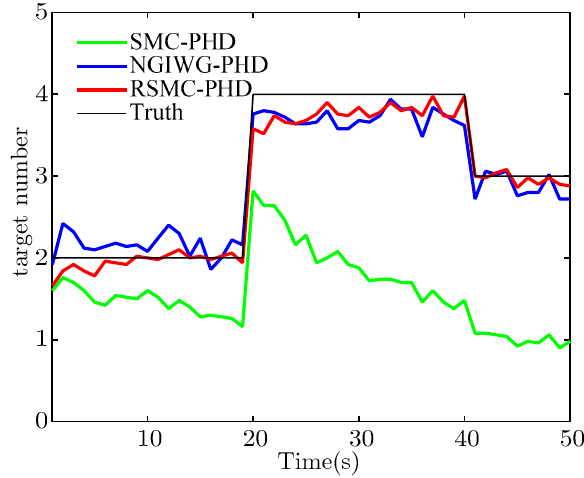
Figure 5. The estimate of target number.